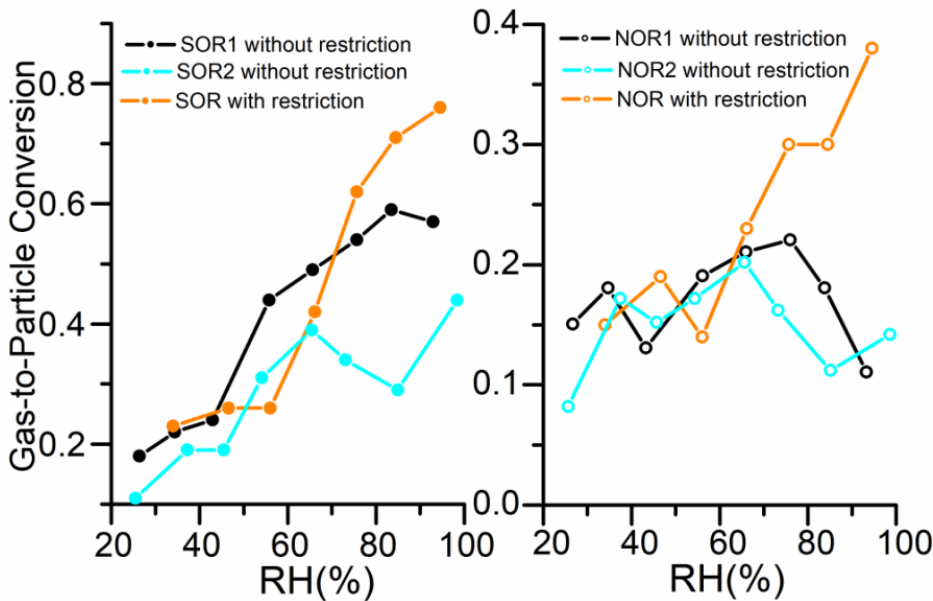
Figure 6. Correlations between SOR, NOR, and RH, and SOR and RH with and without the restriction. Table 2. Average concentration and deviation (in µg m – 3 ) of PM 2.5 , PM 2.5 contents of ions, OM, EC, and precursor gases of SO 2 and NO x ; average rates of gas-to-particle conversion (NOR, SOR); and RH (in %) in the three periods of PP1, PP2, and HOP.